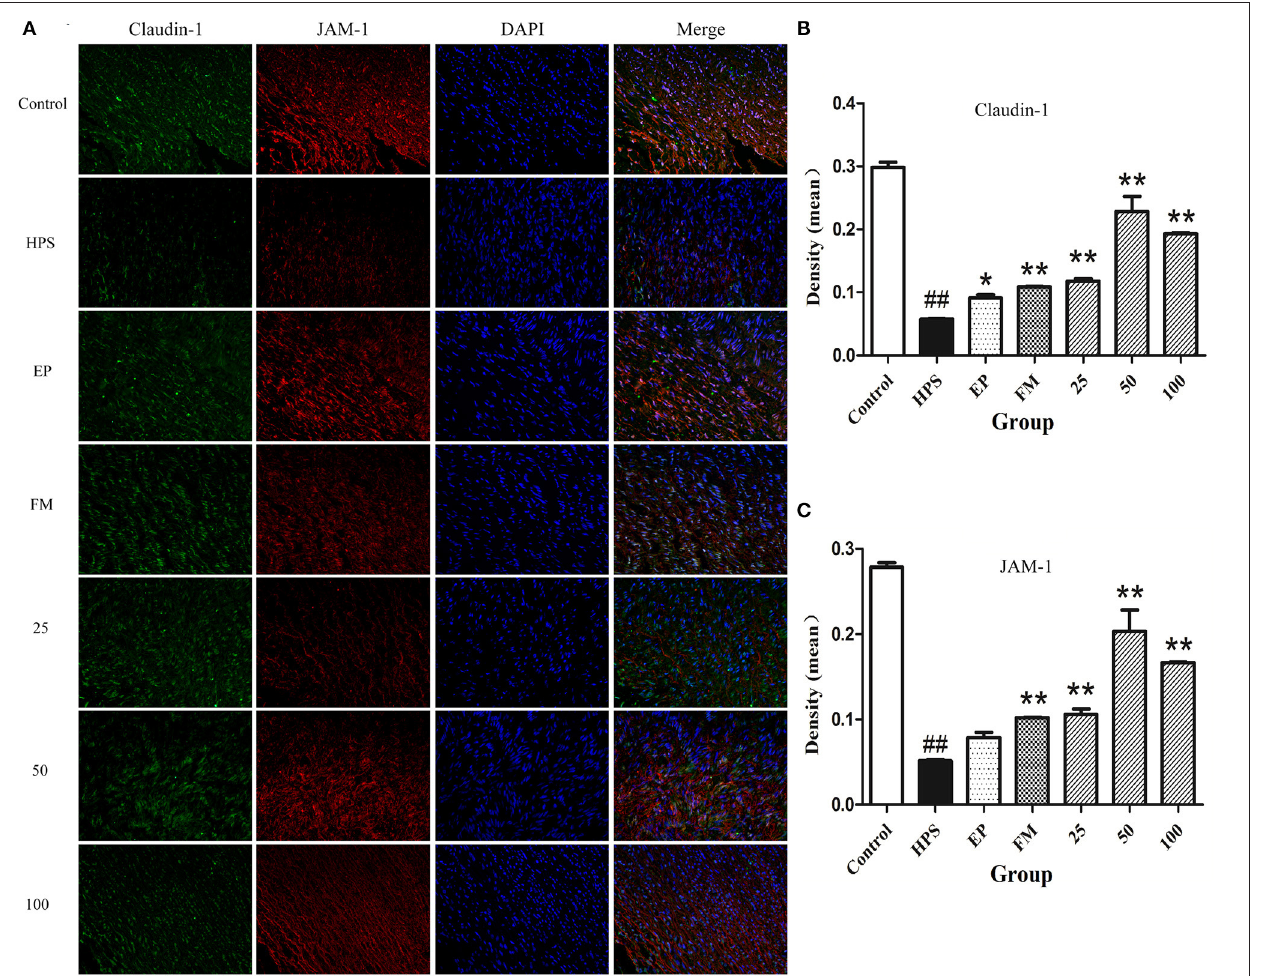
FIGURE 3 | Effects of baicalin on the distribution of claudin-1 and JAM-1 (A) in aorta of piglets challenged with G. parasuis (magnification 10 × 40). Fluorescence of claudin-1 (B) and JAM-1 (C) was measured using Image J. HPS: G. parasuis group, EP: EP + G. parasuis group, FM: FM + G. parasuis group, 25: 25 mg/kg baicalin + G. parasuis group, 50: 50 mg/kg baicalin + G. parasuis group, 100: 100 mg/kg baicalin + G. parasuis group. ## p < 0.01 vs. control, * p < 0.05 vs. G. parasuis group, ** p < 0.01 vs. G. parasuis